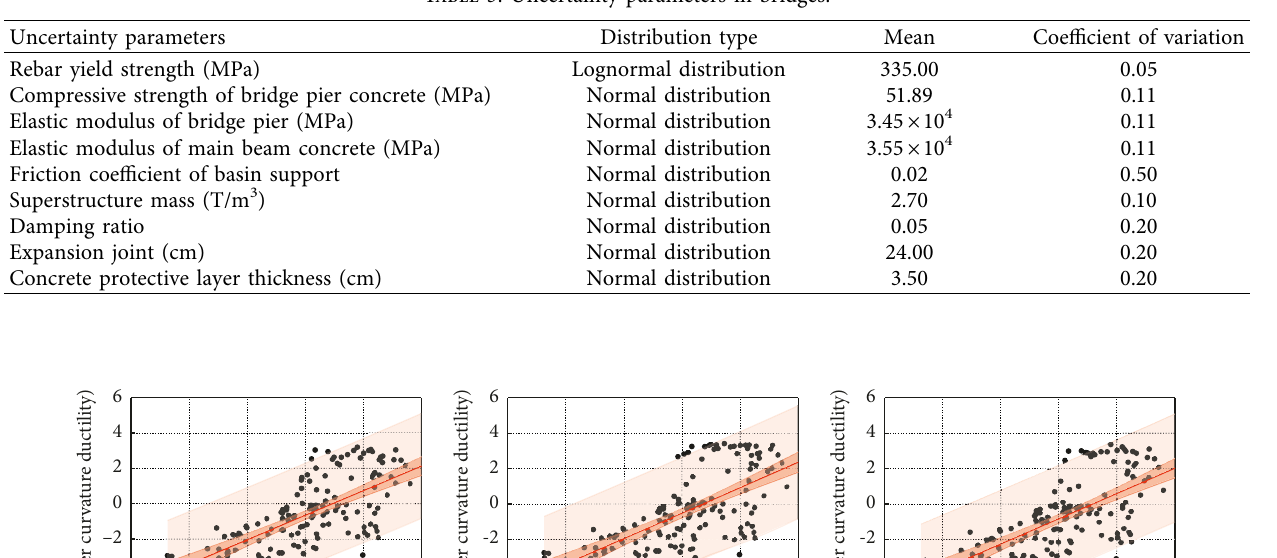
Table 3: Uncertainty parameters in